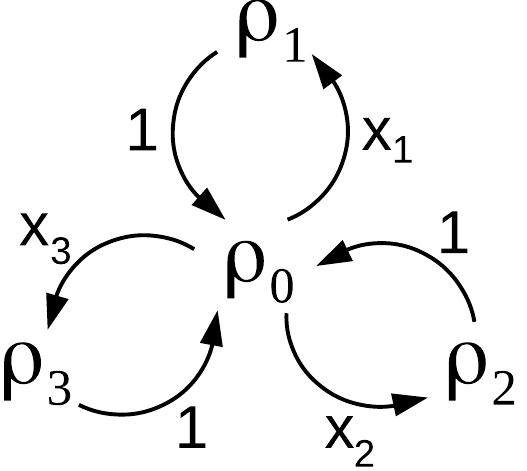
Figure 2. Graphical representation of a master equation (28) with ρ j = σ j ρσ j , with σ 0 = 11, where jumps ρ 0 → ρ 1 occur with rate